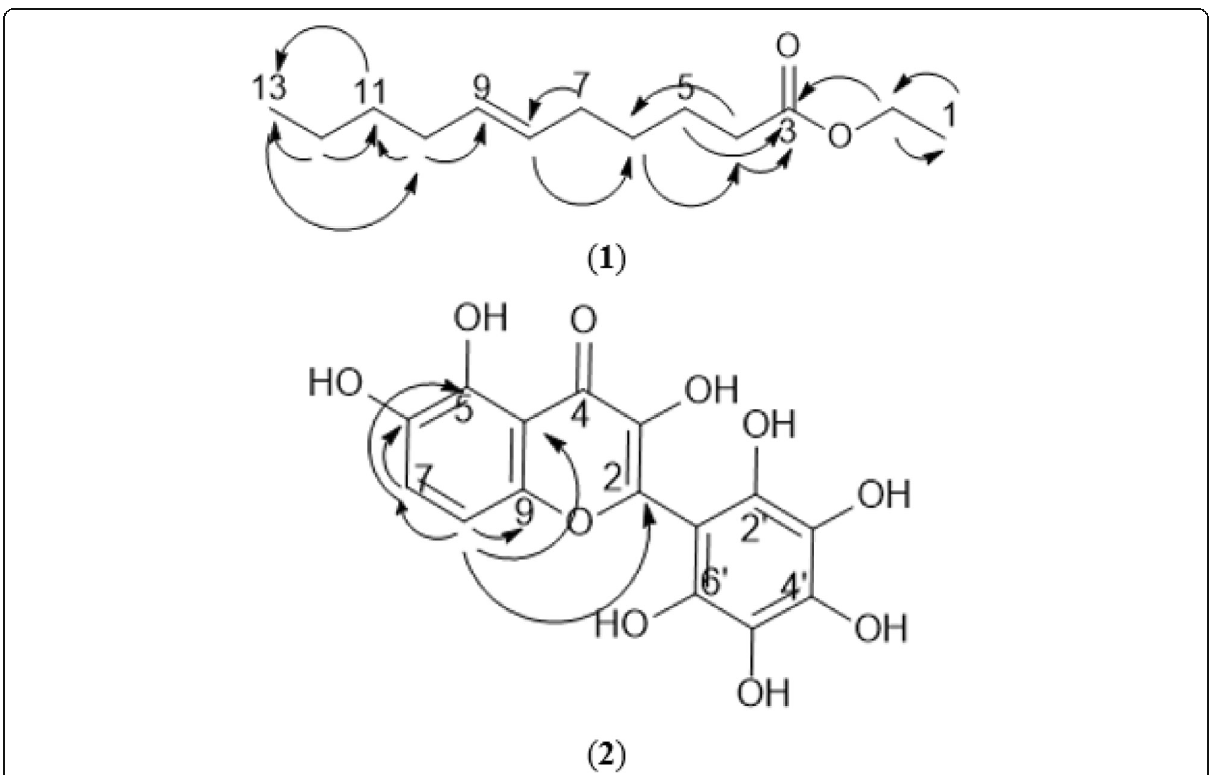
Fig. 2 HMBC of new isolated compounds (1 and